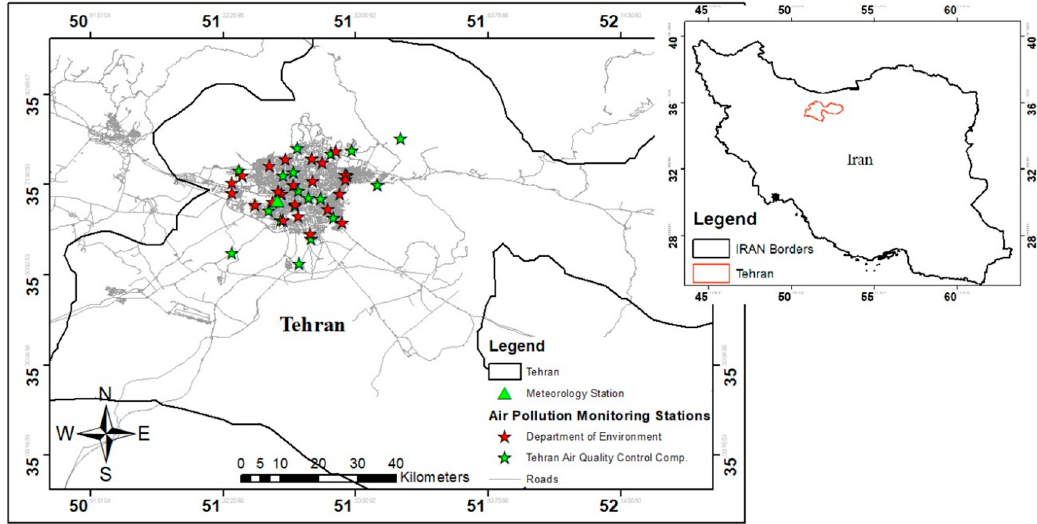
Figure 1. Study area, situated in the northern central part of Iran. There are 42 air pollution monitoring stations installed in the urban area of Tehran by two organizations. The Department of the Environment has 23 monitoring stations (red stars) and the Municipality of Tehran city has 19 stations (green stars). The nearest weather station to the urban area is Mehrabad meteorology station, marked by a green triangle.